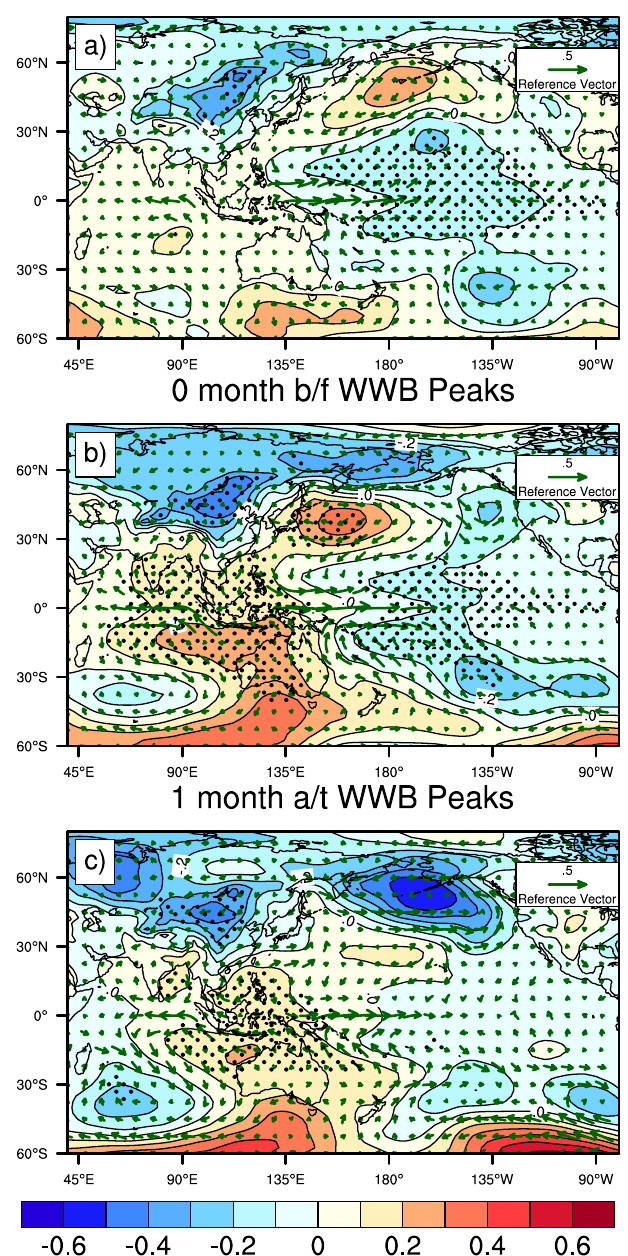
Figure 3. Monthly mean sea level pressure anomalies regressed with IMFs 6–8 from lag 1 months to lead 1 months. The contour interval is 0.1, and the regression coefficients significant at the 99% level according to Student’s t-test are shaded. “1 month a/t WWB Peaks” indicates that IMFs 6–8 leads the SLP anomalies by one month, and the vectors are the winds. Maps were generated using the NCAR Command Language (NCL; https ://www.ncl.ucar.edu/), version 6.6.2 57